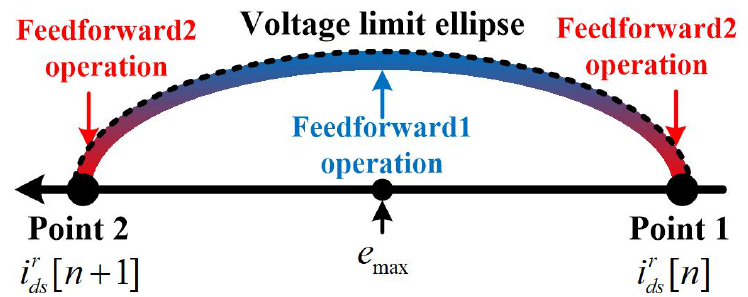
Figure 7. Effective region of each feedforward controller.